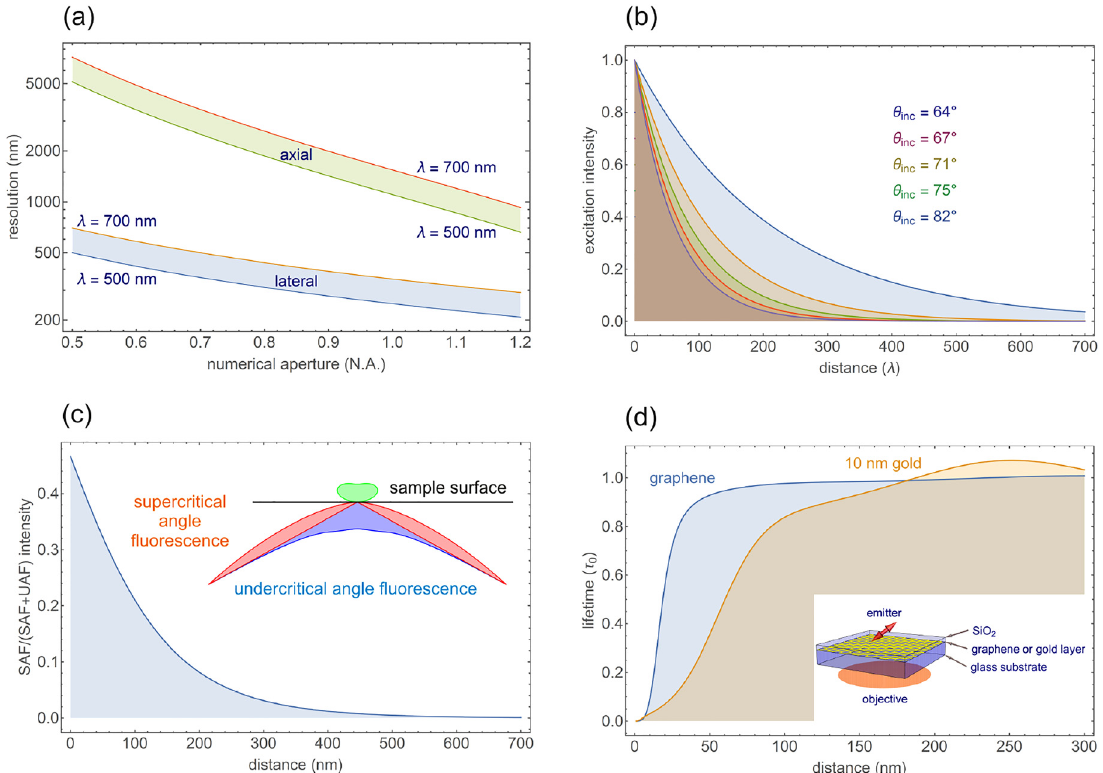
Figure 9: Axial resolution for 3D super-resolution microscopy. (a) Comparison of lateral (lower blue band) and axial (up-per green band) resolution in conventional diffraction-limited optical microscopy with a 1.2 NA water immersion objective. These resolutions are wavelength-dependent and the shown bands span a wavelength range between 500 and 700 nm. (b) Variable angle Total Internal Reflection Microscopy (vaTIRFM). (c) Super-critical Angle Fluorescence (SAF) imaging. (d) Metal-Induced Energy Transfer (MIET) and Graphene-Induced Energy Transfer (GIET)